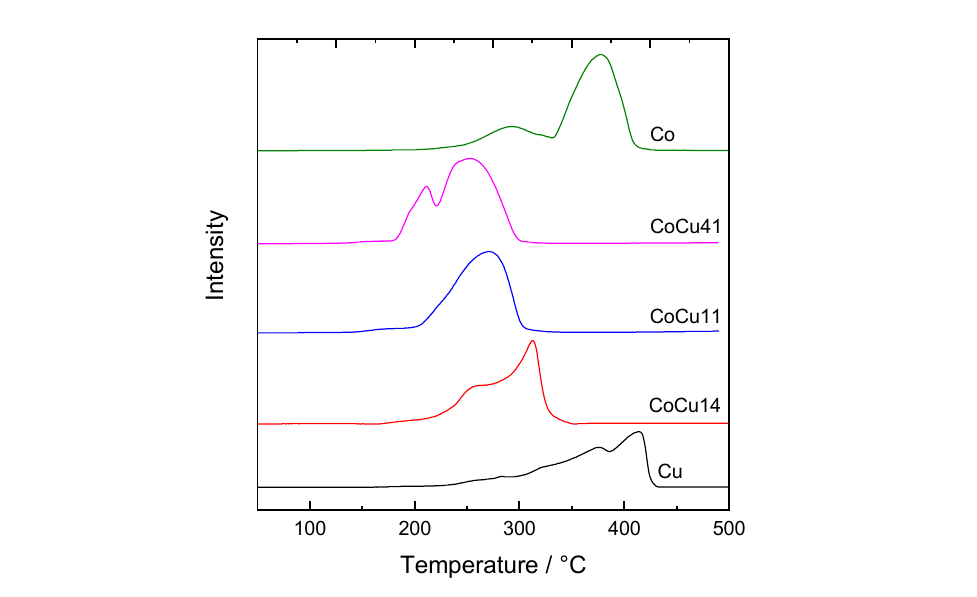
Figure 4. H 2 -temperature programmed reduction profiles of the Co-Cu oxide catalysts. Table 4. H 2 -TPR parameters of the Co-Cu oxide